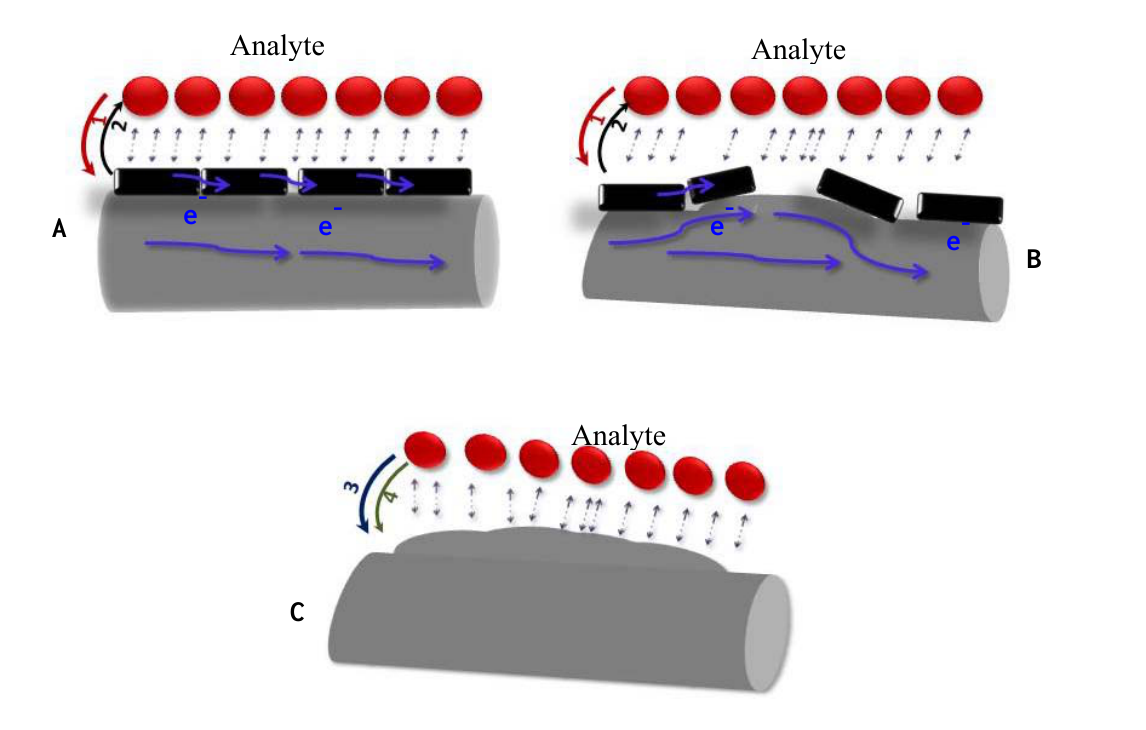
Figure 10. Three possible modes of analyte interactions: (A) Analyte exposure to MWCNTs directly; (B) Partial exposure of analyte to Nylon-6 and MWCNTs; (C) Analyte exposure to Nylon-6 polymer directly. Possible predominant mechanism: (1) electron transfers from analyte to MWCNTs if analyte is electron donor; (2) electron transfers from MWCNTs to analyte if analyte is electron acceptor; (3) electron transfers from analyte to polymer; (4) physical adsorption of analyte on Nylon-6 polymer that causes